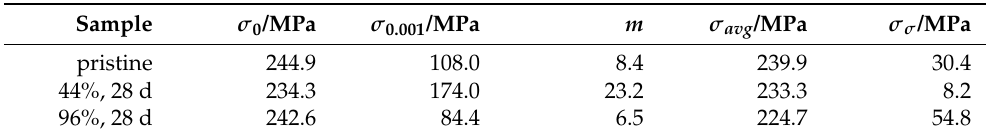
Table 2. Characteristic strengths σ 0 and σ 0.001 , Weibull moduli m , average fracture strengths σ avg and the fracture strengths’ corresponding standard deviation σ σ of the pristine sample and the samples stored for 28 days in 44% r.h. and 96% r.h.